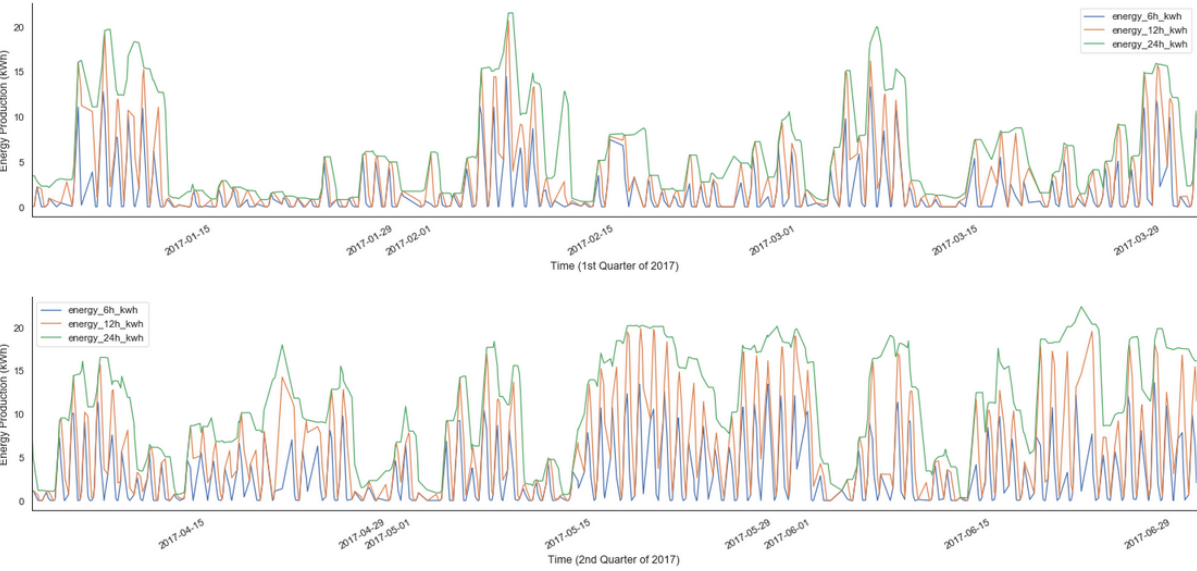
Figure 9: Distribution the energy production over 6, 12 and 24 hour time windows for the 1st and 2nd quarter of